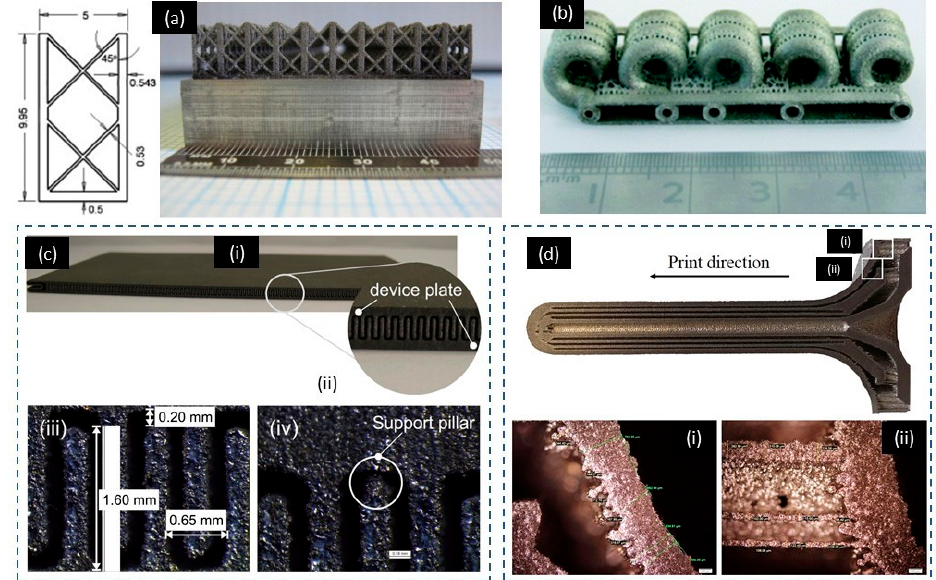
Figure 11. Example of Powder-based 3D-printed heat transfer devices and heat switch ( a ) SLM 3D-printed heat transfer device. Reproduced with permission from [229]; ( b ) SLM 3D-printed mesoscale flow reactors. Reproduced with permission from [231]; ( c ) SLM 3D-printed compact heat switch. Reproduced with permission from [121]; ( d ) high-temperature aerospace resistojet heat exchanger 3D-printed by SLM 3D-printing process. Reproduced with permission from [233].